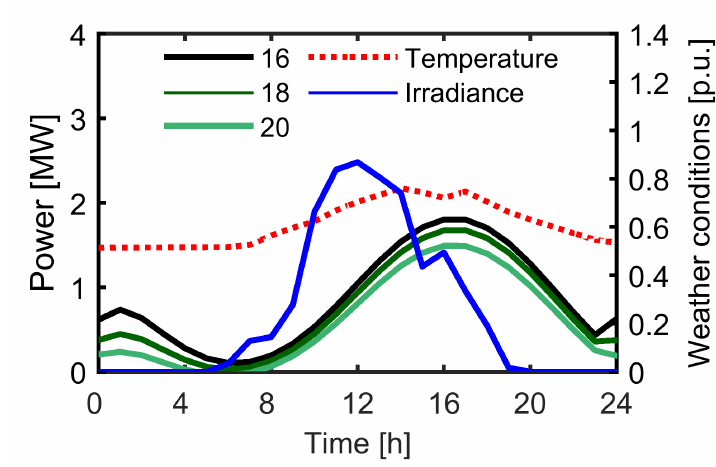
Figure 11. Parametric study for TmHAVC influence on the HAVC disaggregated electric power component on an example summer day. Temperature and irradiance are reported in p.u. with reference to base values of 40 ◦ C and 1000 W/m 2 .